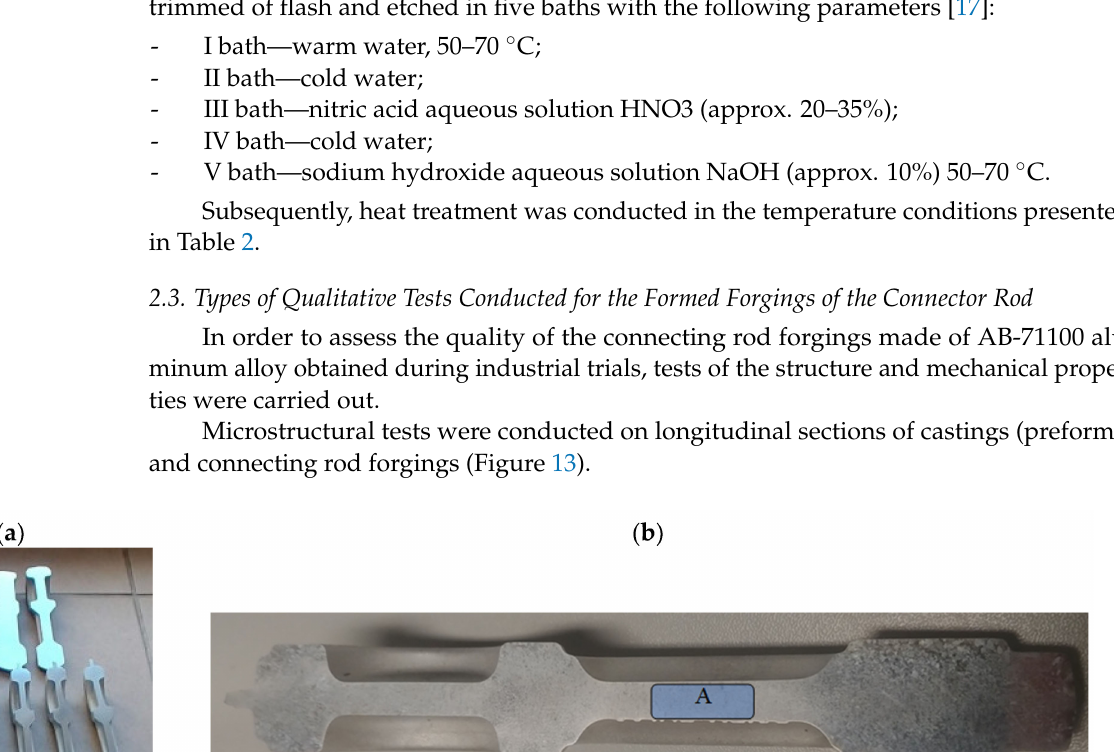
Figure 12. An example of a connecting rod preform (variant 1) placed in the finishing impression (beginning of the process) ( a ) and forging formed on the press (end of the process) ( b ). After forging on each of the machines (crank press, screw press), the forgings were trimmed of flash and etched in five baths with the following parameters [17]: